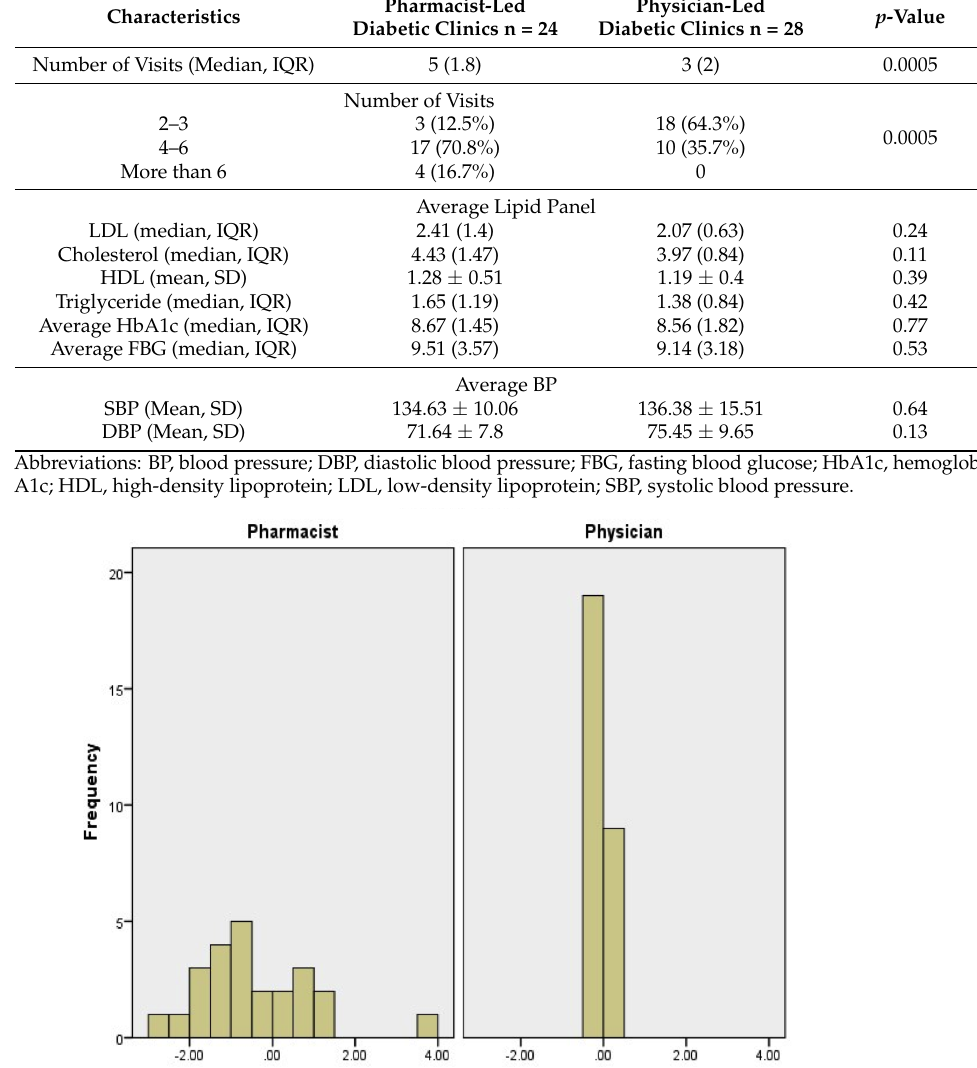
Table 3. Difference in HbA1c and other biomedical parameters. Pharmacist-Led Physician-Led Characteristics Diabetic Clinics n = 24 Diabetic Clinics n = 28 Table 4. Changes in diabetic medication doses. Number of Visits (Median, IQR) Number of Changed Pharmacist-Led Doses Per Patient